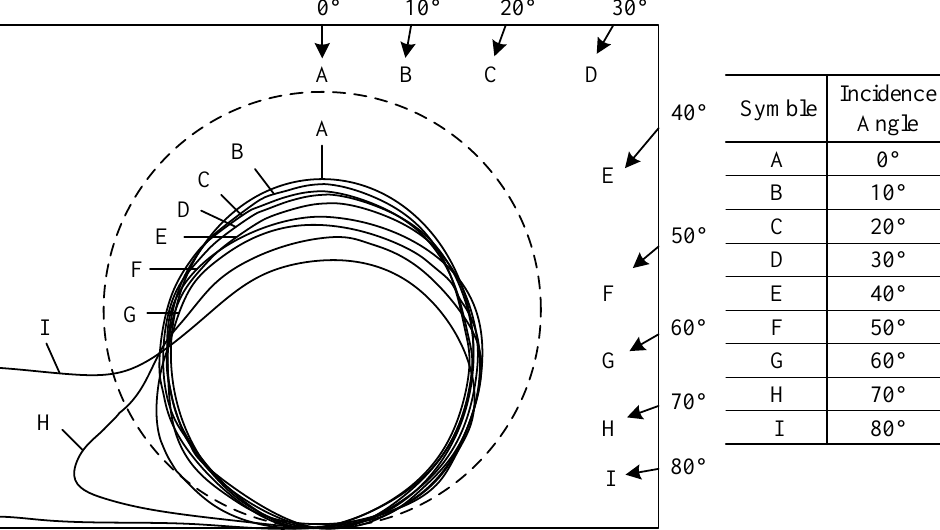
Figure 3. Diffuse reflection polar diagram of a plaster wall.